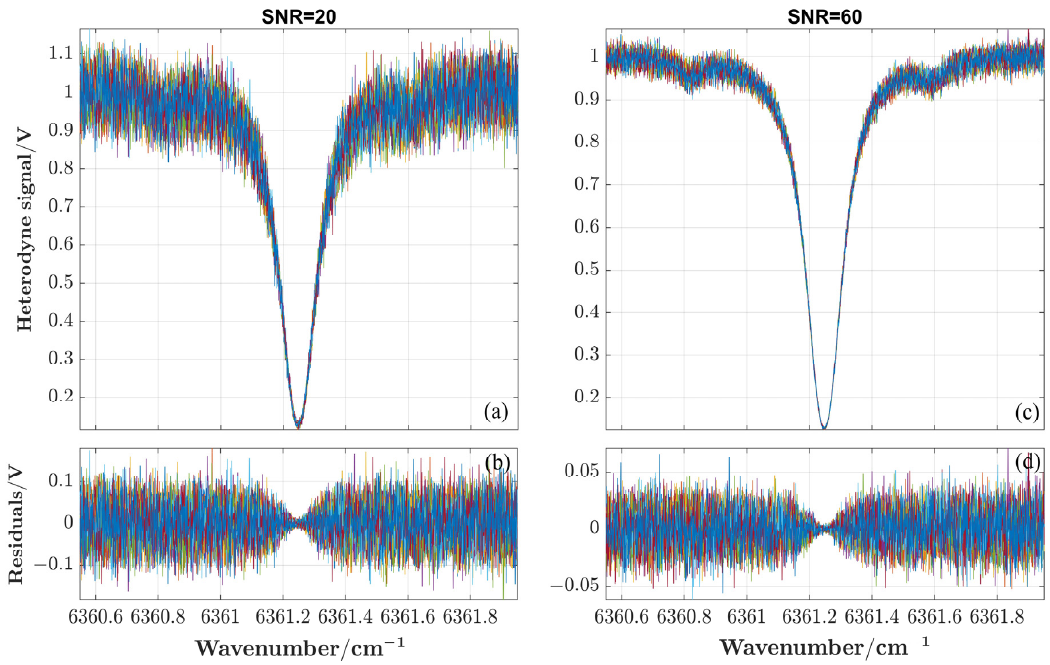
Figure 7. The simulated multiple heterodyne-signals at SNR of ( a ) 20, and ( c ) 60, respectively; the residuals between multiple heterodyne-signals at SNR of ( b ) 20, and ( d ) 60, respectively. Table 2. Retrieval results of different SNR statistics.